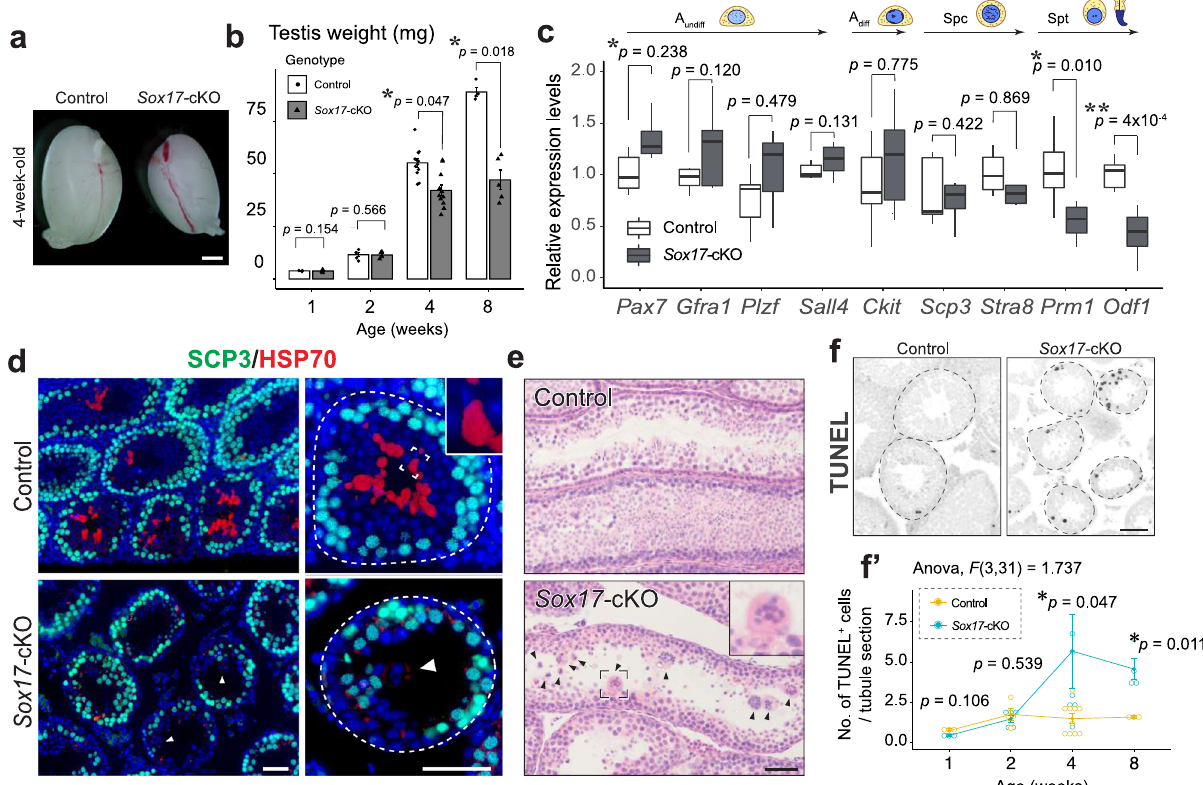
Fig.6|Aberrantspermiogenesisin Sox17- cKOtestes.a Grossmorphologyofthe testis from 4-week-old Sox17- cKO and their littermate controls. b The decrease of testicularweightin Sox17- cKOmicefrom4weeksofageonward.1wk:Control n =3, Sox17- cKO n =4,2wk:Control n =5, Sox17- cKO n =4,4wk:Control n =12, Sox17- cKO n =11, 8wk: Control n =4, Sox17- cKO n =5. c RT-qPCR analysis of the whole testis from 4-week-old Sox17- cKO and control group animals. Expression levels of spermatid-speci fi c marker genes were signi fi cantly decreased in Sox17- cKO